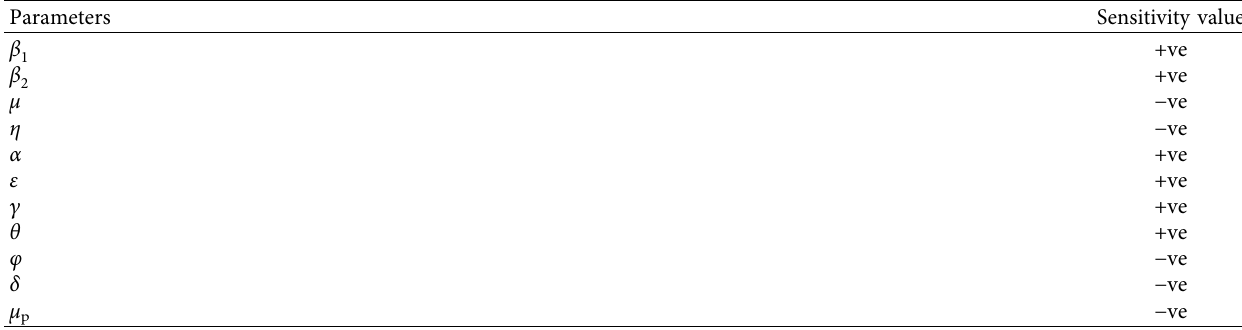
Table 3: Sensitivity indices of the parameters.